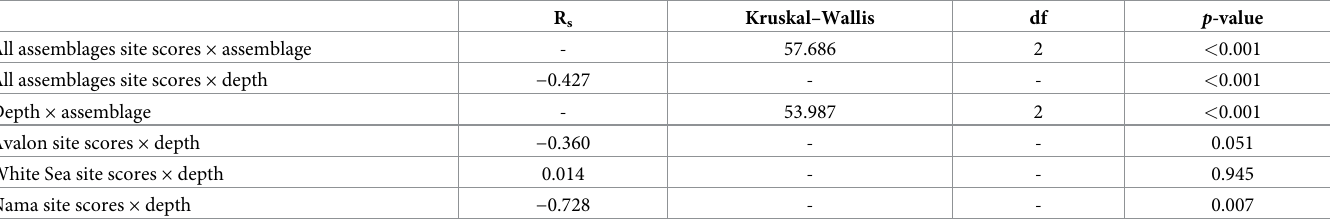
Table 2. Reciprocal averaging analyses. Spearman rank correlations (R s ) (for continuous variables) and Kruskal–Wallis tests (for discrete variables) between site scores of each dataset obtained from reciprocal averaging and a variable, either assemblage or depth. R s Kruskal–Wallis df p -value All assemblages site scores × assemblage - 57.686 2 < 0.001 All assemblages site scores × depth − 0.427 - - < 0.001 Depth × assemblage - 53.987 2 < 0.001 Avalon site scores × depth − 0.360 - 0.051 White Sea site scores × depth 0.014 0.945 -